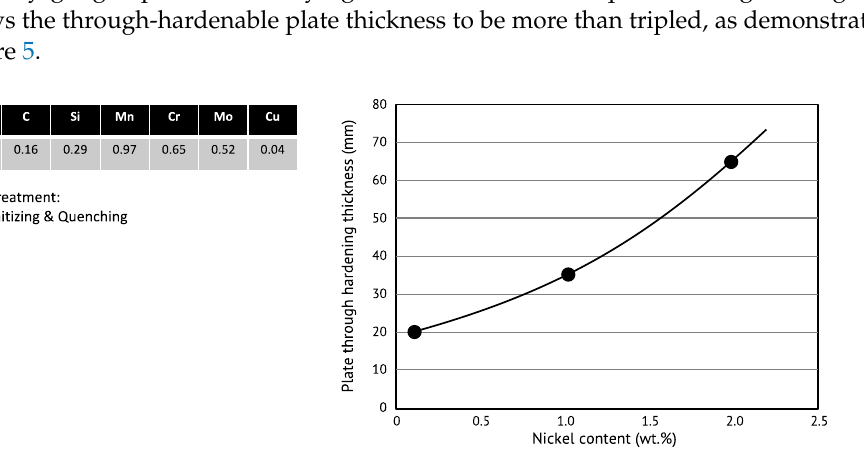
Figure 5. Impact of nickel alloying on through ‐ thickness hardening in a heat ‐ treatable steel.